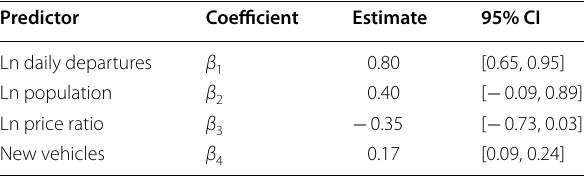
Table 1 Estimated coefficients with 95% confidence